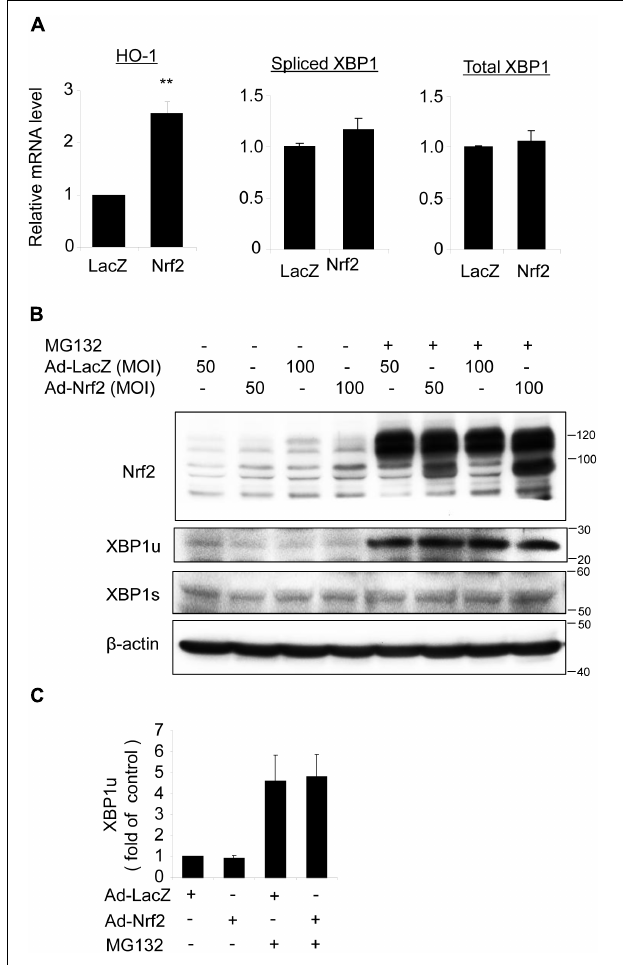
FIGURE 7 | Overexpression of Nrf2 does not alter XBP1 expression in ARPE-19 cells. (A) ARPE-19 cells were transfected with adenovirus overexpressing Nrf2 or LacZ as control for 24 h, mRNA level of HO-1, spliced XBP1 and total XBP1 was determined by real-time RT PCR (mean ± SD, n = 3, ∗∗ p < 0.01 vs. ad-LacZ transfected cells). (B) ARPE-19 cells were transfected with adenovirus overexpressing Nrf2 or LacZ for 48 h, Nrf2, unspliced XBP1 (XBP1u) and spliced XBP1 (XBP1s) level was detected by Western blot analysis (representative of 3 independent